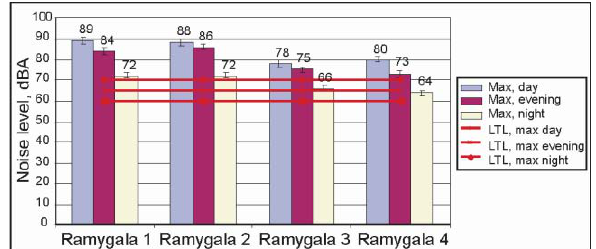
Fig. 7. Dynamics of maximum noise levels in Ramygala street within twenty four